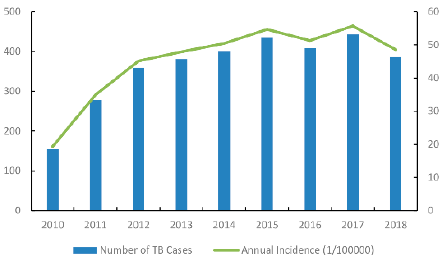
Figure 2. Annual tuberculosis case numbers and incidences in the new urban area of Nanchang from 2010 to 2018.